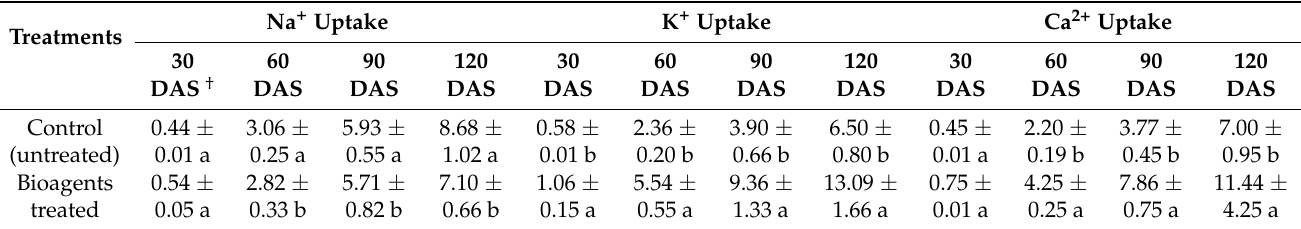
Table 5. Effect of bioagents on Na + , K + and Ca 2+ uptake in plants (kg ha − 1 ) grown under salt stress conditions. Treatments